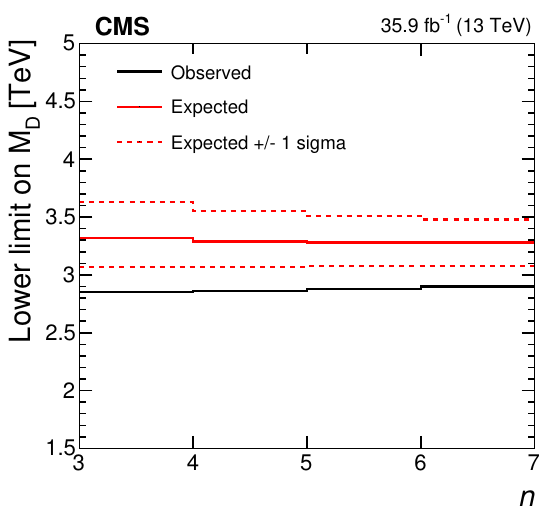
Figure 11 . Lower limit on M D as a function of n , the number of ADD extra dimensions. n Obs. limit [TeV] Exp. limit [TeV]